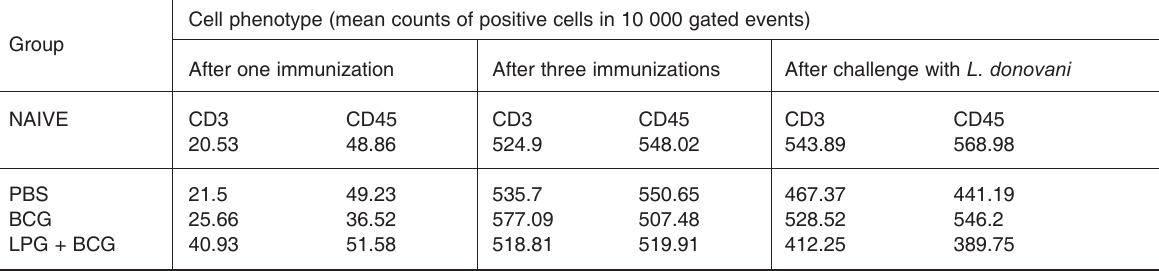
TABLE 2 Comparison of the percentage of CD3 and CD45 cells drawn from BALB/c mice following immunization with the respec- tive antigen and after challenge infection with virulent L. donovani parasites Cell phenotype (mean counts of positive cells in 10 000 gated events) Group After one immunization After three immunizations After challenge with L. donovani